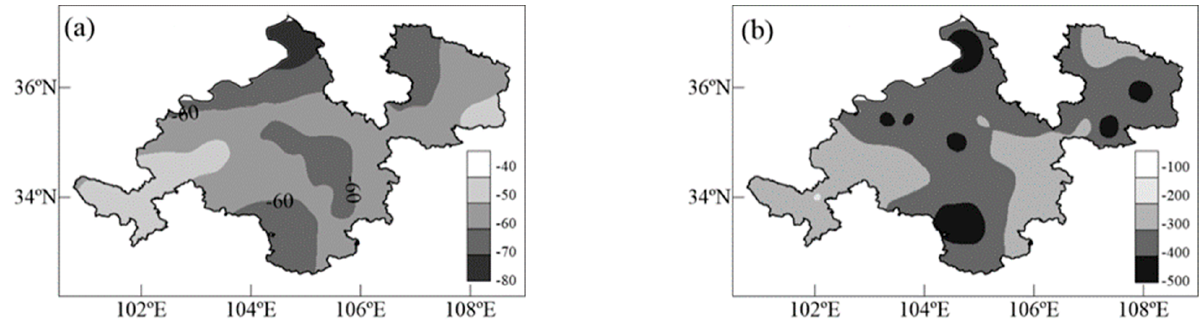
Figure 4. Average ( a ) and maximum intensity ( b ) of drought processes during 1960–2017.